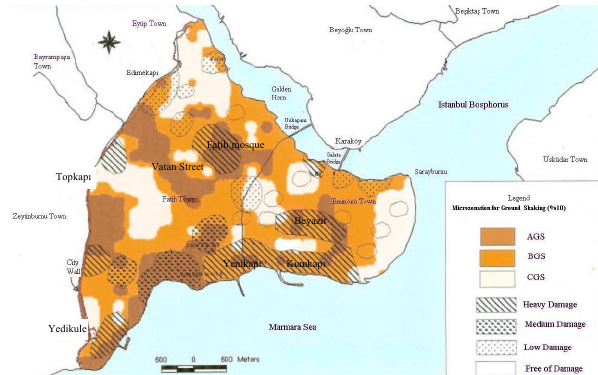
Figure 10. Regional Damage Map of 1894 Earthquake (Lav, 1994).